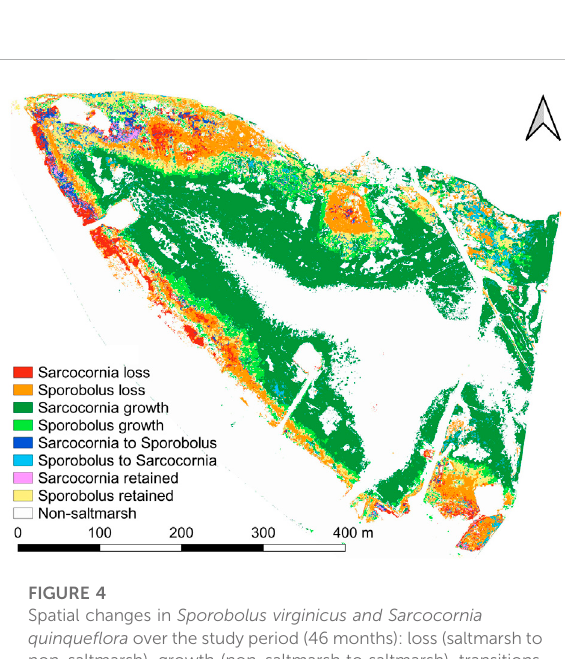
FIGURE 4 Spatial changes in Sporobolus virginicus and Sarcocornia quinque fl ora over the study period (46 months): loss (saltmarsh to non-saltmarsh), growth (non-saltmarsh to saltmarsh), transitions between species and retention (saltmarsh retained over time).